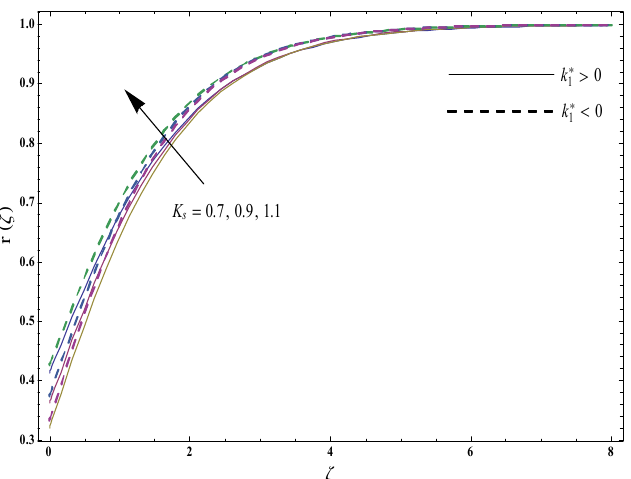
Figure 11. Variations of concentration rate for homogeneous-reaction strength when Sc b = 1.0, K s = 0.5 and M = 0.2.